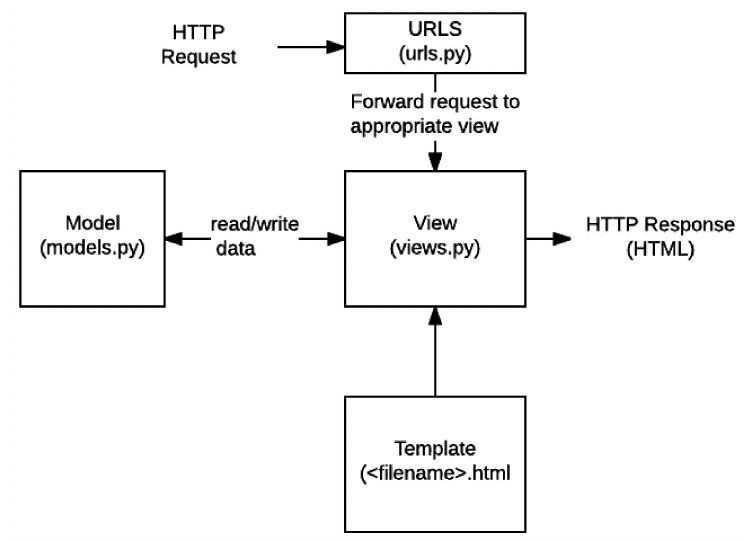
Figure 3. Django